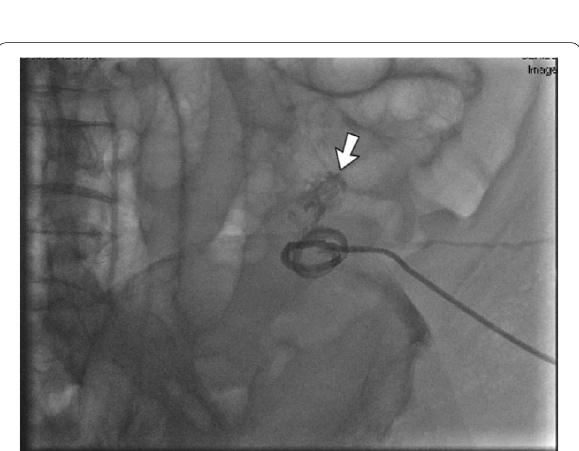
Fig. 3 IR drain study with fluoroscopy demonstrating a fistulous tract to the colon (arrow), with absent intraperitoneal fluid